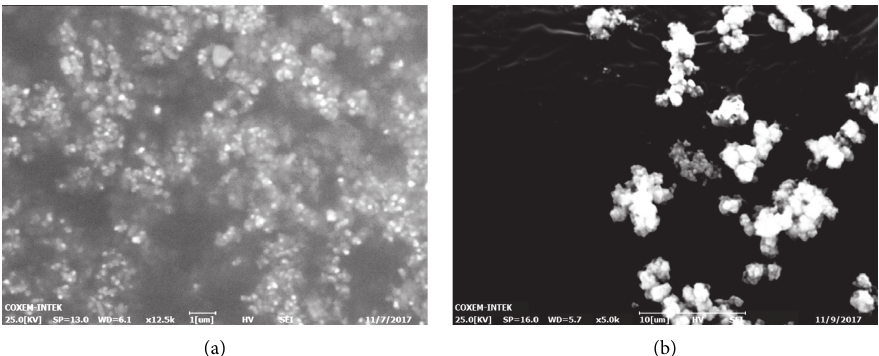
Figure 13: Image of AgNPs as assessed by SEM. AgNPs added to the oocyst and bacteria (a). AgNPs recuperated after of exposure to oocyst